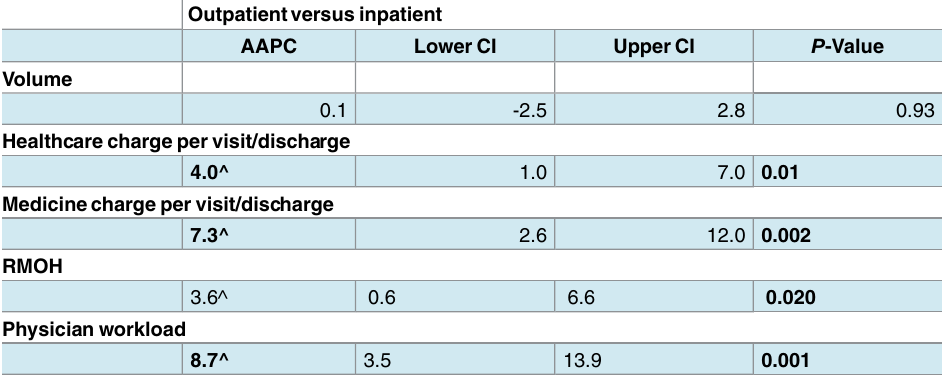
Table 5. Comparison of the outpatient and inpatientservicechangesassociated of the zero-markup policyimplemented in Dec 2012 at the JishuitanHospitalat Xinjiekoucampus, Beijing,China. Outpatientversus